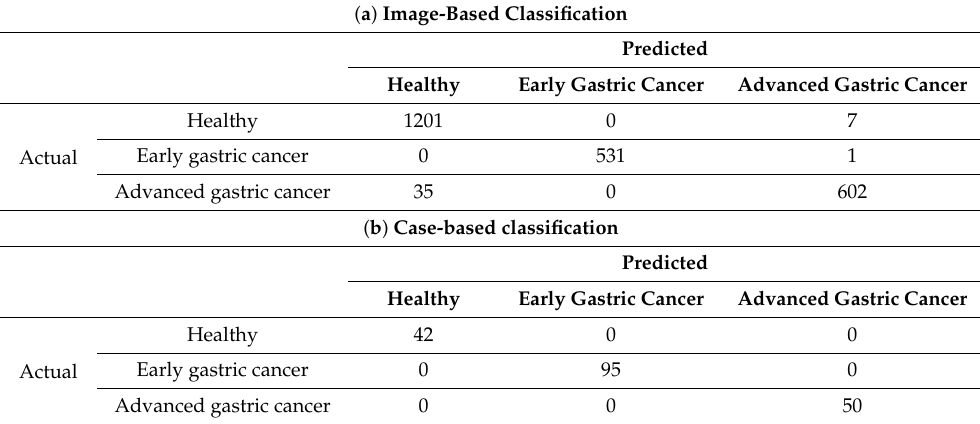
Table 2. Confusion matrices of classification using